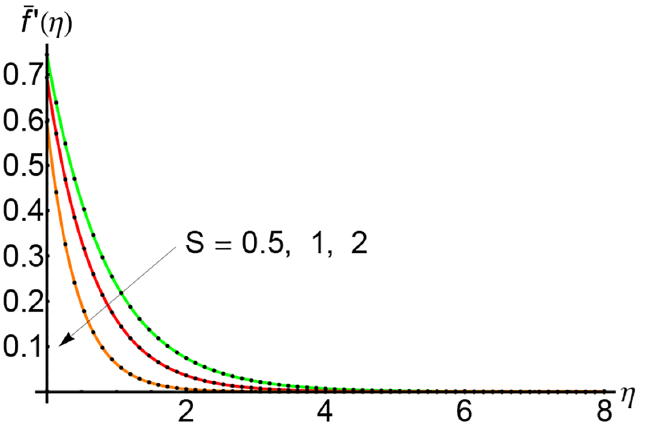
Fig 7. Variation of horizontal velocity (cid:2) f 0 ð Z Þ with η for different values of suction parameter S and for λ = 0.3: —— numerical solution ......... . OHPM solution.